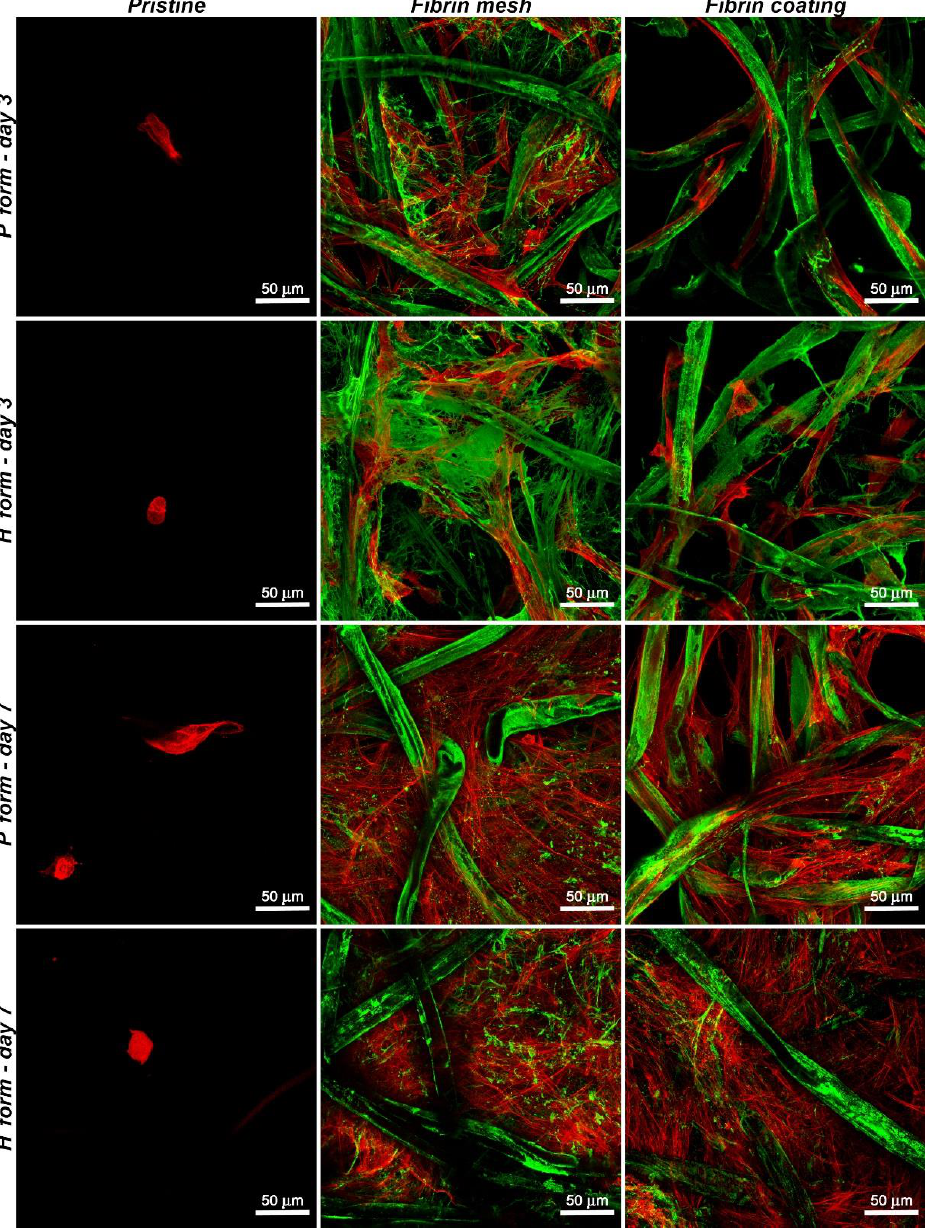
Figure 4. Morphology of human dermal fibroblasts on the P form and on the H form of Hcel ® NaT, in pristine state and modified with a fibrin mesh or a fibrin coating on day 3 or day 7 after cell seeding. The fibrin was stained with the primary and secondary antibodies mentioned above (Alexa 488, green), and the F-actin cytoskeleton was stained with phalloidin-TRITC (red). Leica TCS SPE DM 2500 confocal microscope, magnification 40×/1.15 NA oil.